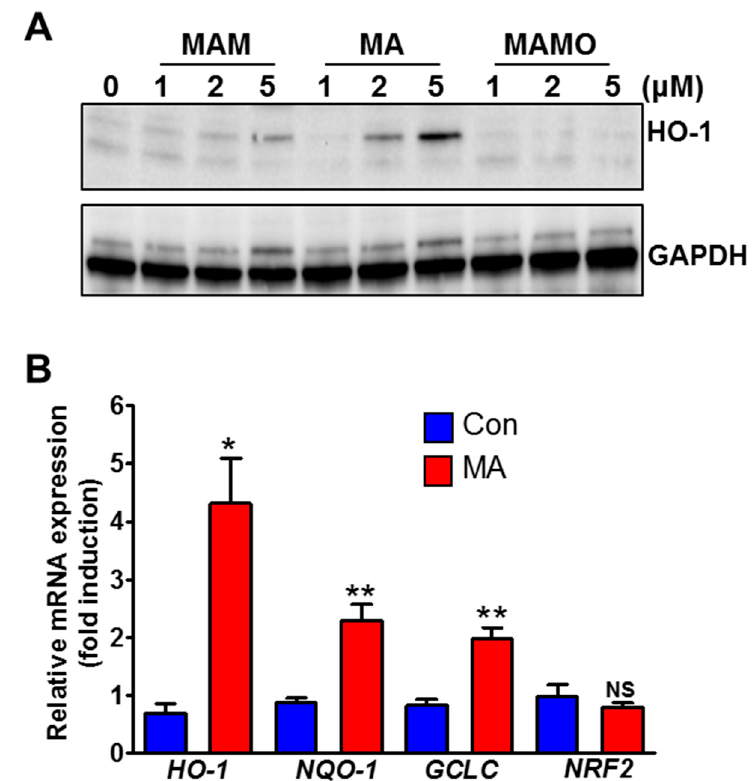
Figure 2. MA increases NRF2 target genes in HeLa cells. ( A ) Western blot analysis of HO-1 by juglone derivatives. ( B ) Real time-PCR analysis of NRF2 target genes after treatment with MA (5 µM) for 17 h. * p < 0.05, ** p < 0.001.